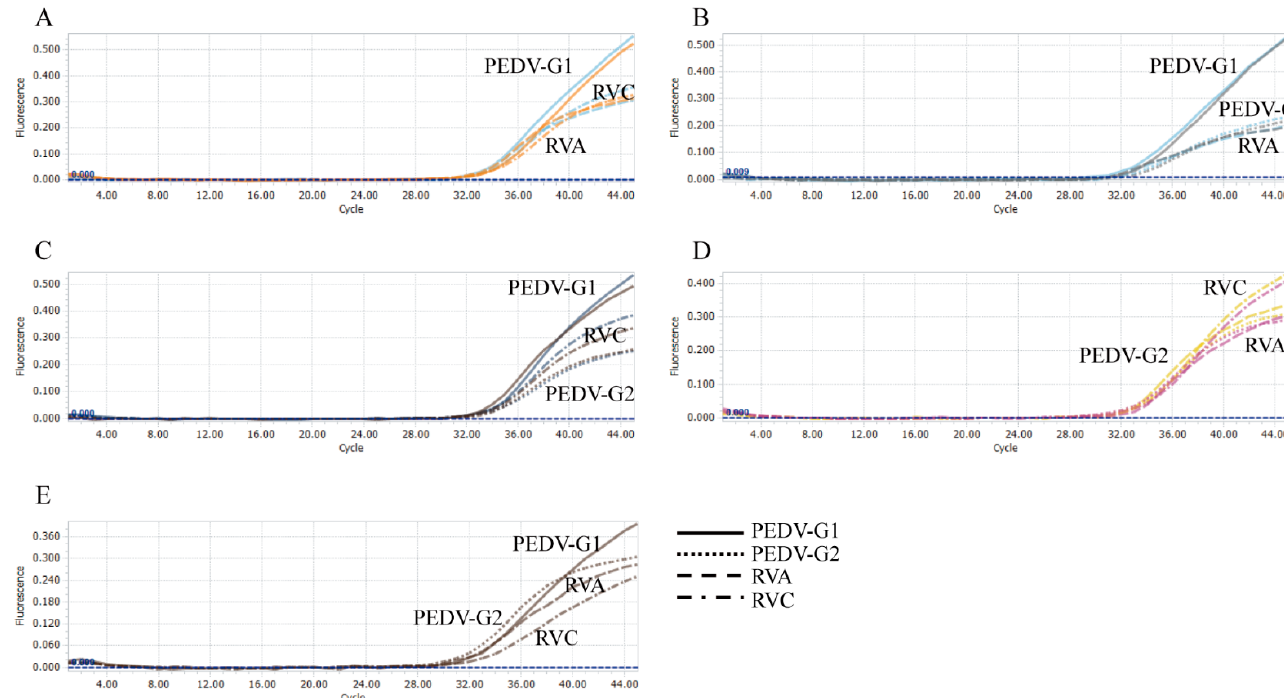
Figure 4. Co-infection simulation experiments with three and four pathogens. ( A ) amplification curves (X-axis: cycle, Y-axis: fluorescence) of PEDV-G1, RVA, and RVC at concentrations of the LOD. ( B ) amplification curves (X-axis: cycle, Y-axis: fluorescence) of PEDV-G1, PEDV-G2, and RVA at concentrations of the LOD. ( C ) amplification curves (X-axis: cycle, Y-axis: fluorescence) of PEDV-G1, PEDV-G2, and RVC at concentrations of the LOD. ( D ) amplification curves (X-axis: cycle, Y-axis: fluorescence) of PEDV-G2, RVA, and RVC at concentrations of the LOD. ( E ) amplification curves (X-axis: cycle, Y-axis: fluorescence) of PEDV-G1, PEDV-G2, RVA, and RVC at concentrations of the LOD.